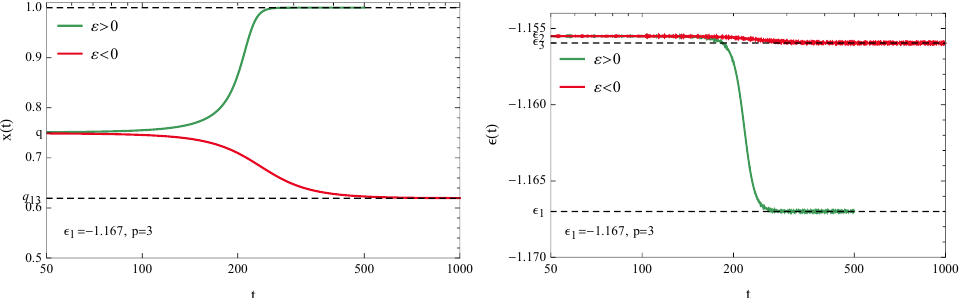
Figure 10: Results of the numerical integration of dynamical relaxation with kick of positive (negative) amplitude are represented in green (red). Left. Overlaps